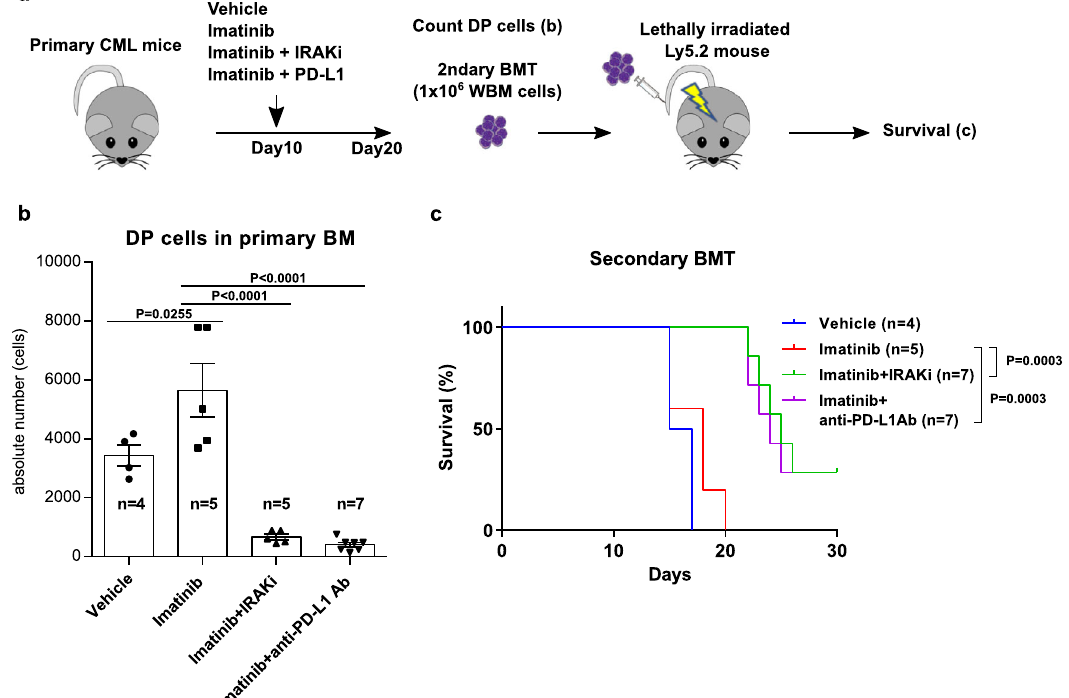
Fig. 6 A combination of imatinib and IRAK1/4 inhibitors or anti-PD-L1 antibody ef fi ciently reduces the number of CML LSCs. a Experimental design. b Absolute number of DP cells in the BM from primary recipient mice in the indicated treatment groups ( n = 4 (Vehicle), 5 (Imatinib), 5 (Imatinib + IRAKi), and 7 (Imatinib + PD-L1)). c Survival curves for secondary recipient mice transplanted with whole BM cells from primary recipient mice in the indicated treatment groups ( n = 4 (Vehicle), 5 (Imatinib), 7 (Imatinib + IRAKi) and 7 (Imatinib + PD-L1)). Data are shown as the mean ± SEM. P values are calculated using one-way ANOVA with Tukey ’ s correction for multiple comparisons ( b ) or log-rank test ( c